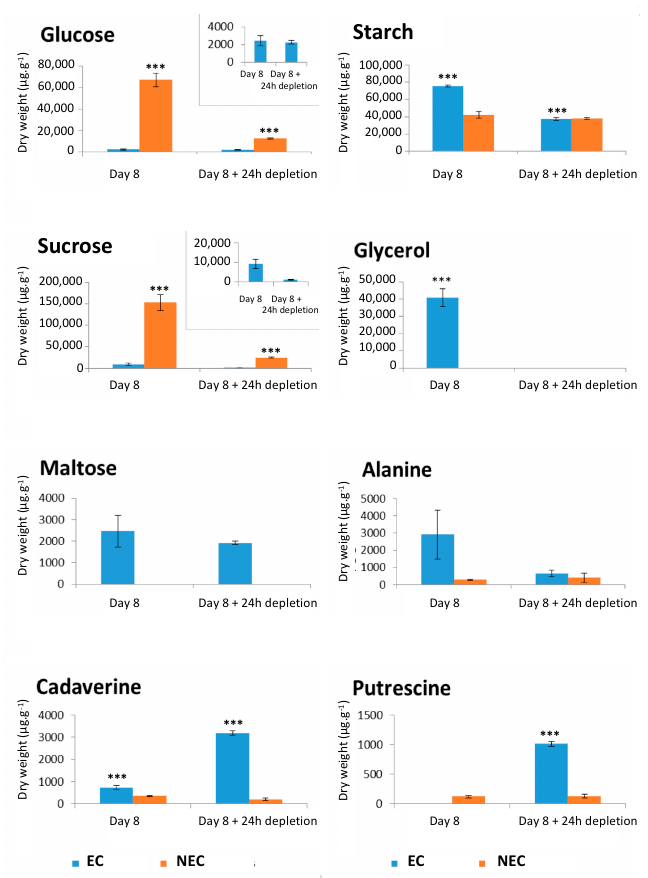
Figure 10. Shifts in concentration of soluble metabolites in embryogenic cells (EC) and non-embryogenic cells (NEC) grown under two conditions: 8 days of culture (D8) and 8 days of culture followed by 24 h of depletion (D8 + 24 h). The soluble metabolites were measured by 1 H NMR. Starch was quantitated by an enzymatic method. The presented results correspond to the mean values of three independent biological replicates (±SEM). The asterisks denote the groups that were found significantly different by ANOVA with Tukey’s multiple comparison test (*** p < 0.001) .